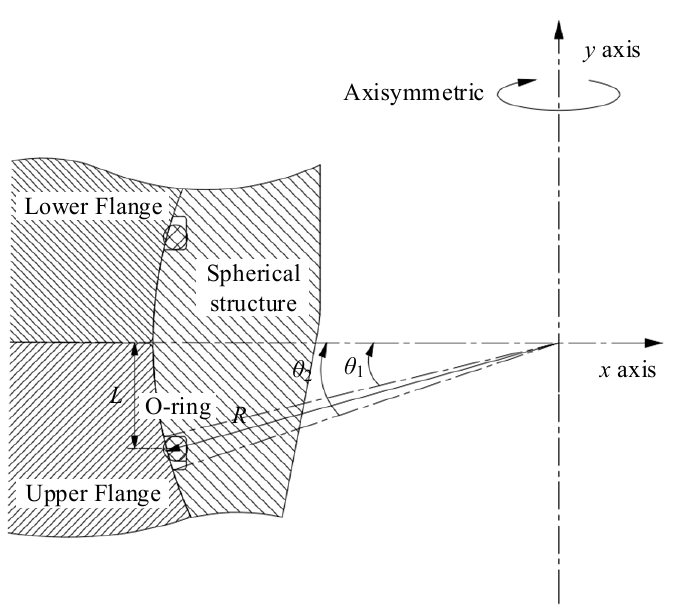
Figure 4. Diagram of O-ring sealing position structure.